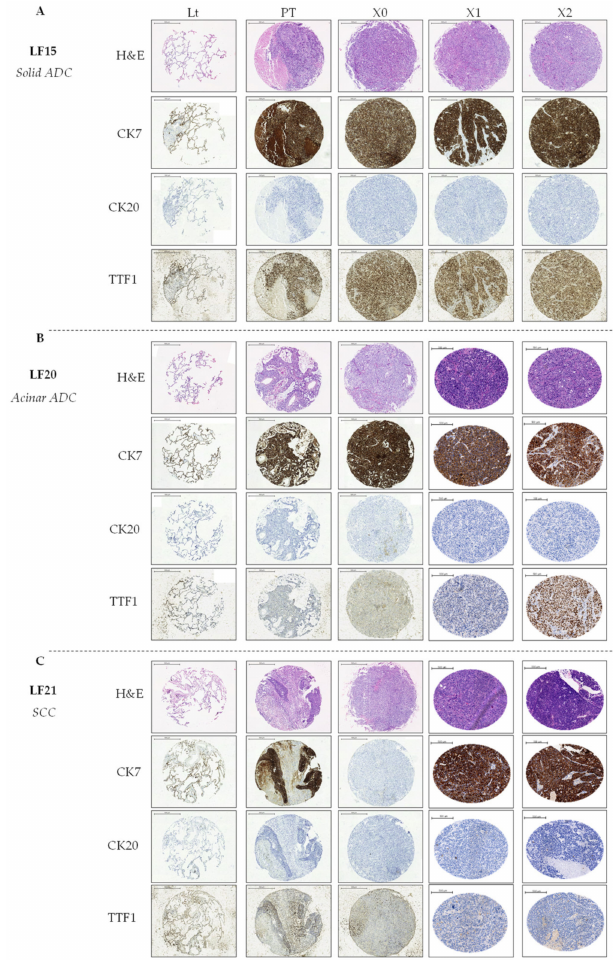
Figure 4. Representative images of surgically resected tumor and patient-derived xenograft (PDX) tissues on H&E and CK7, CK20, and TTF-1 staining of three different NSCLC tumors. Adjacent lung tissue (Lt), primary tumor (PT), and three PDX passages (X0–X2) are shown. All images are at 5 ×